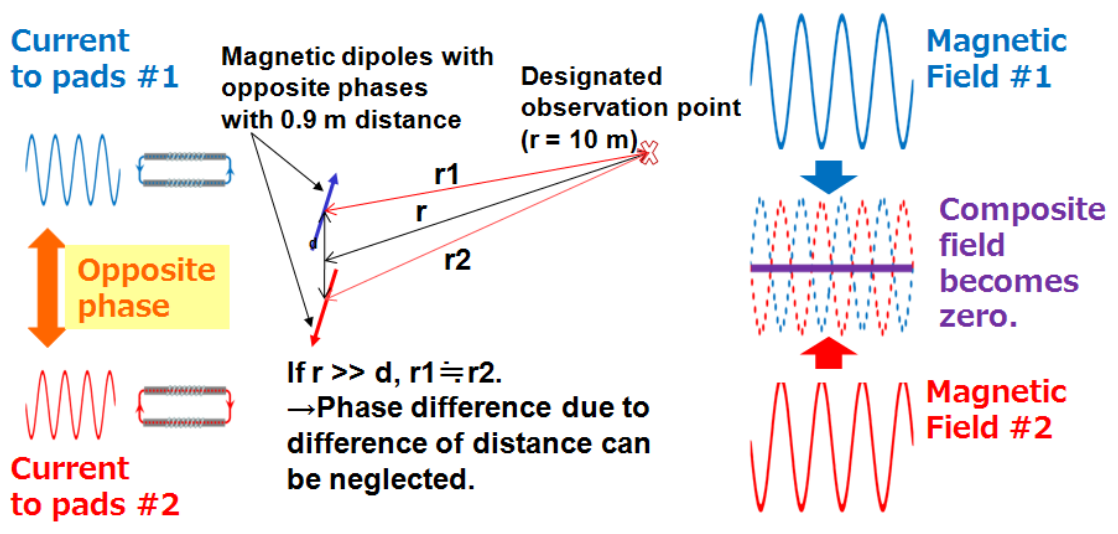
Figure 2. Opposite-phase-current feeding for suppression of magnetic radiation.